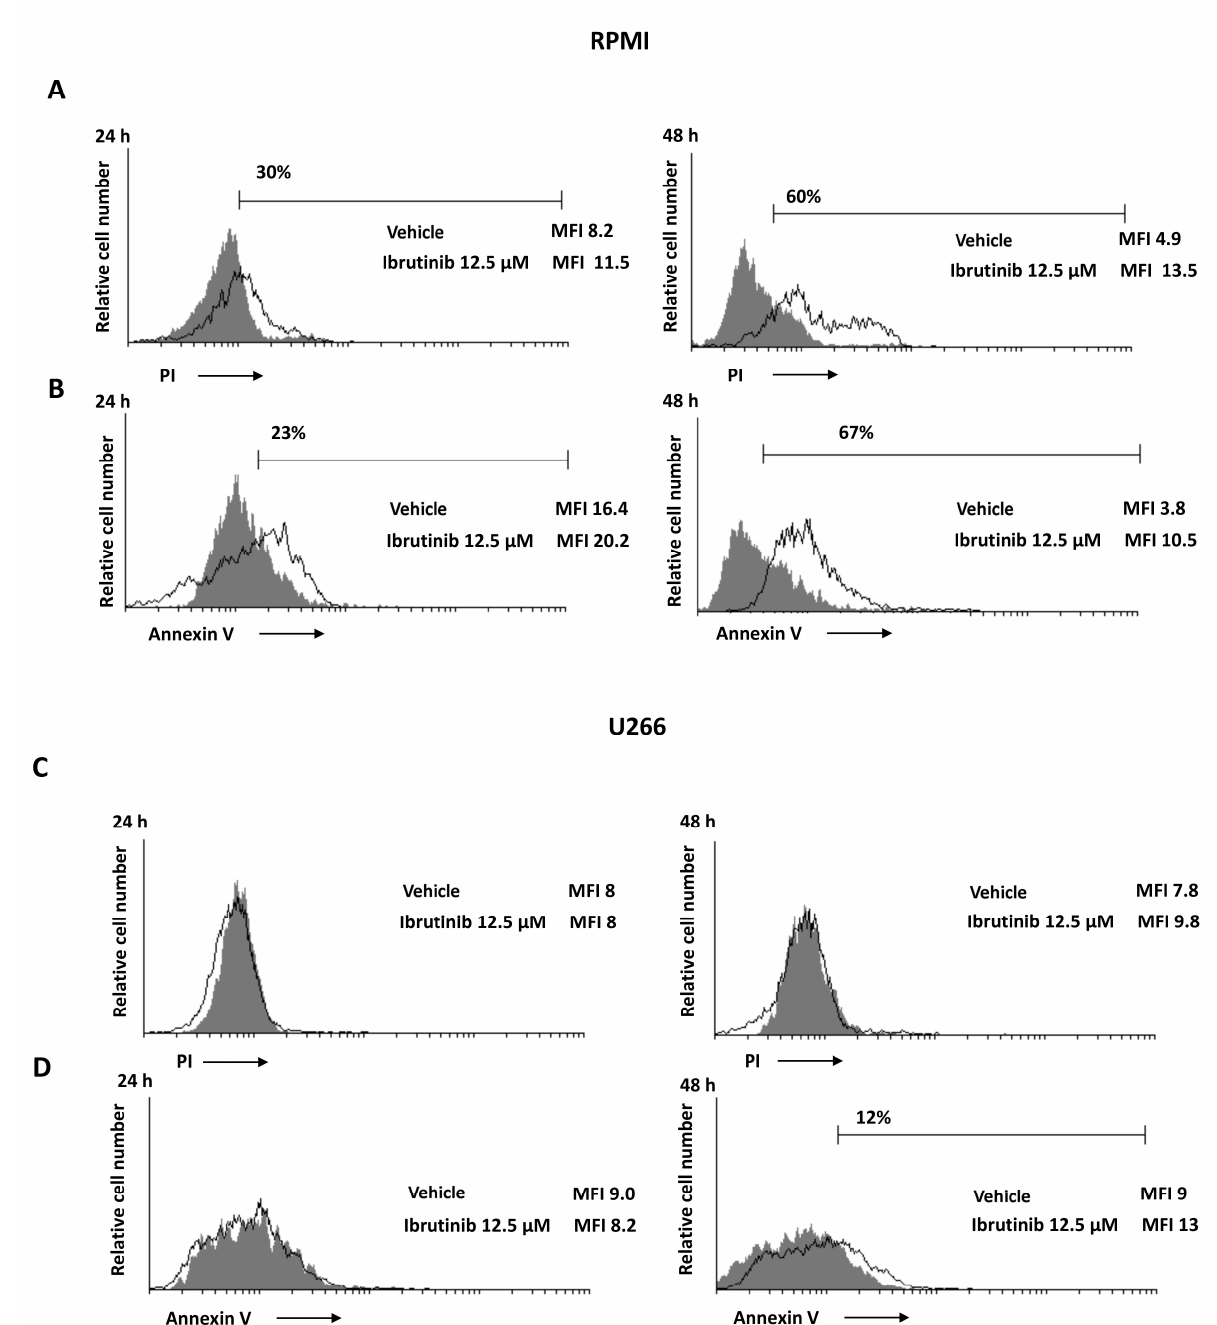
Figure 3. Ibrutinib induces cell death in MM cells. ( A , C ) PI incorporation was analysed by flow cytometry in RPMI and U266 treated with Ibrutinib for 24 and 48 h. Histograms are representative of one of three separate experiments. ( B , D ) Flow cytometric analysis was performed by Annexin V-FITC staining in MM cells treated as above described. Histograms are representative of one of three separate experiments. MFI = mean fluorescence intensity.